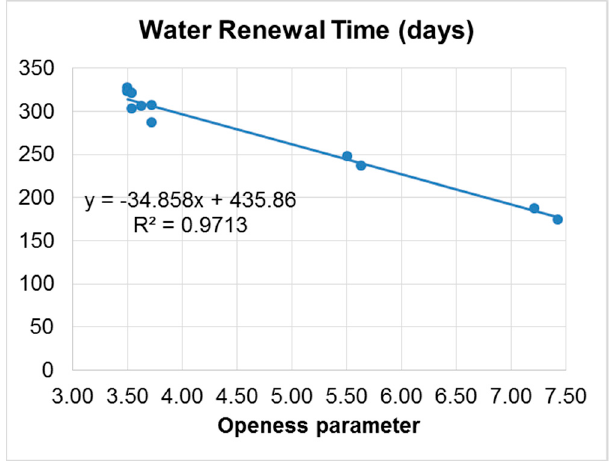
Figure 14. Relationship between the openness parameter and water renewal time.